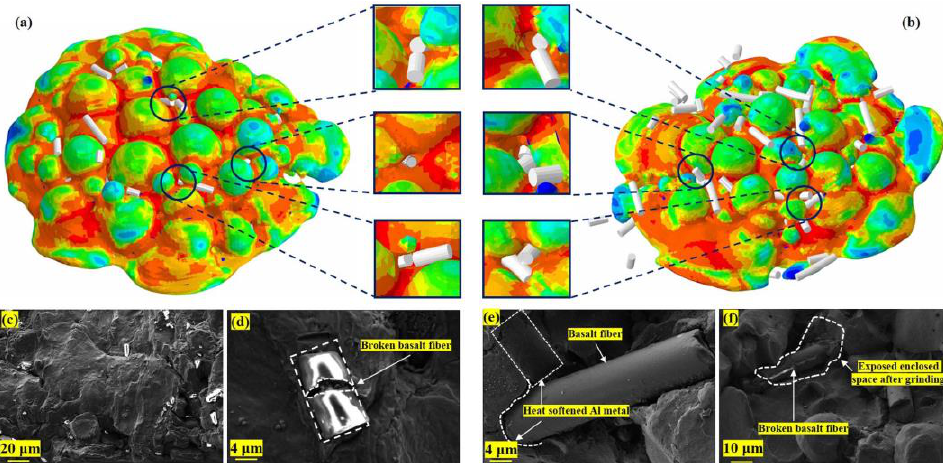
Figure 11. Stochastic deposition simulation of Al – basalt fiber mixed multi-particle. ( a ) Deposition with 15 vol.% CBF; ( b ) CBF 30 vol.% deposition; ( c ) composite coating cross-section; ( d ) fractured CBF; ( e ) trace pit after CBF exfoliation; ( f ) CBF with cracks.